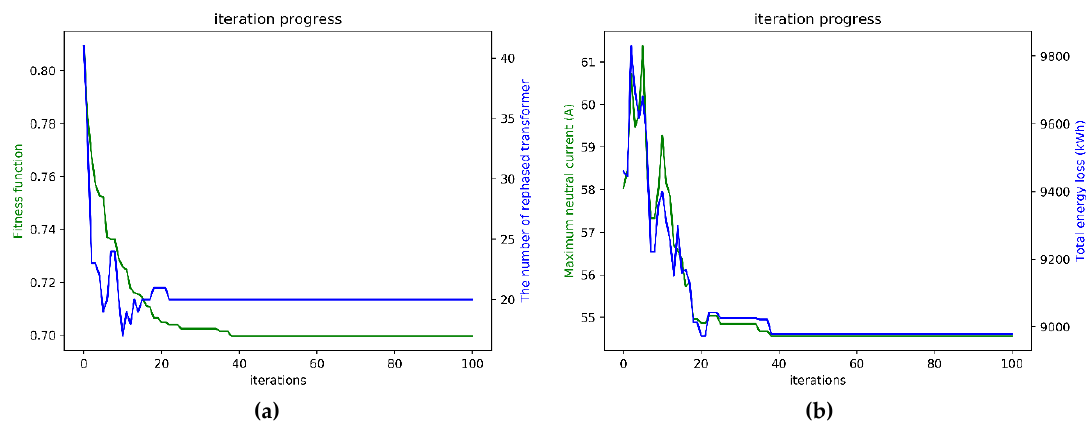
Figure 18. The iterative convergence diagram of Case 2: ( a ) fitness function and rephasing number and ( b ) neutral current and total energy loss.